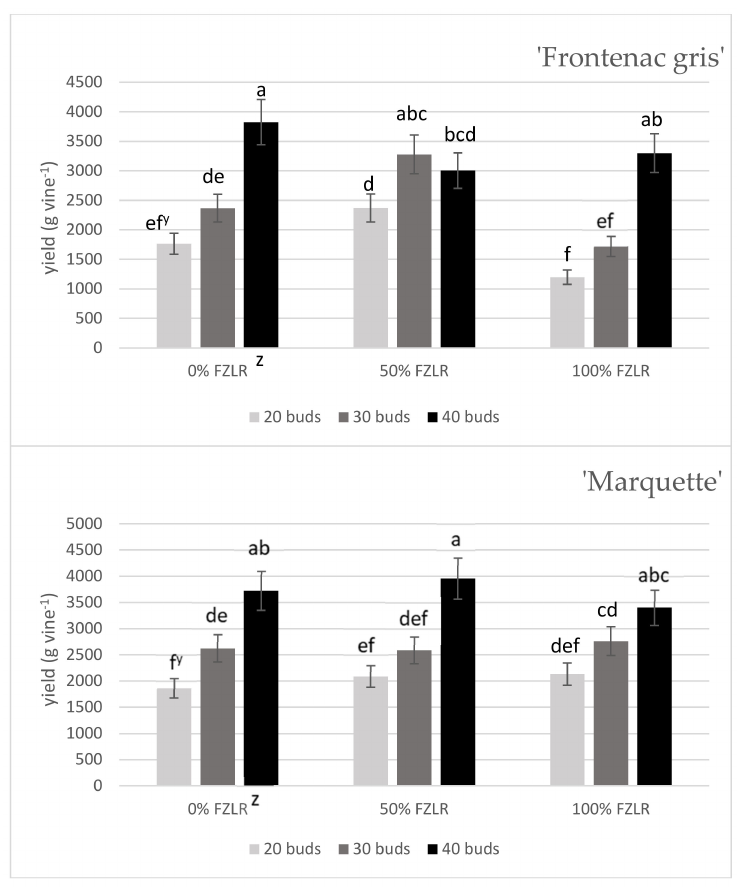
Figure 1. E ff ect of grape cultivar, bud retention, and fruit-zone leaf removal percentage on fruit yield of two V. riparia -based cultivars averaged over locations and years; z abbreviation FZLR = fruit-zone leaf removal; y means followed by the same letter(s) are not significantly di ff erent according to Duncan’s multiple range test at p <